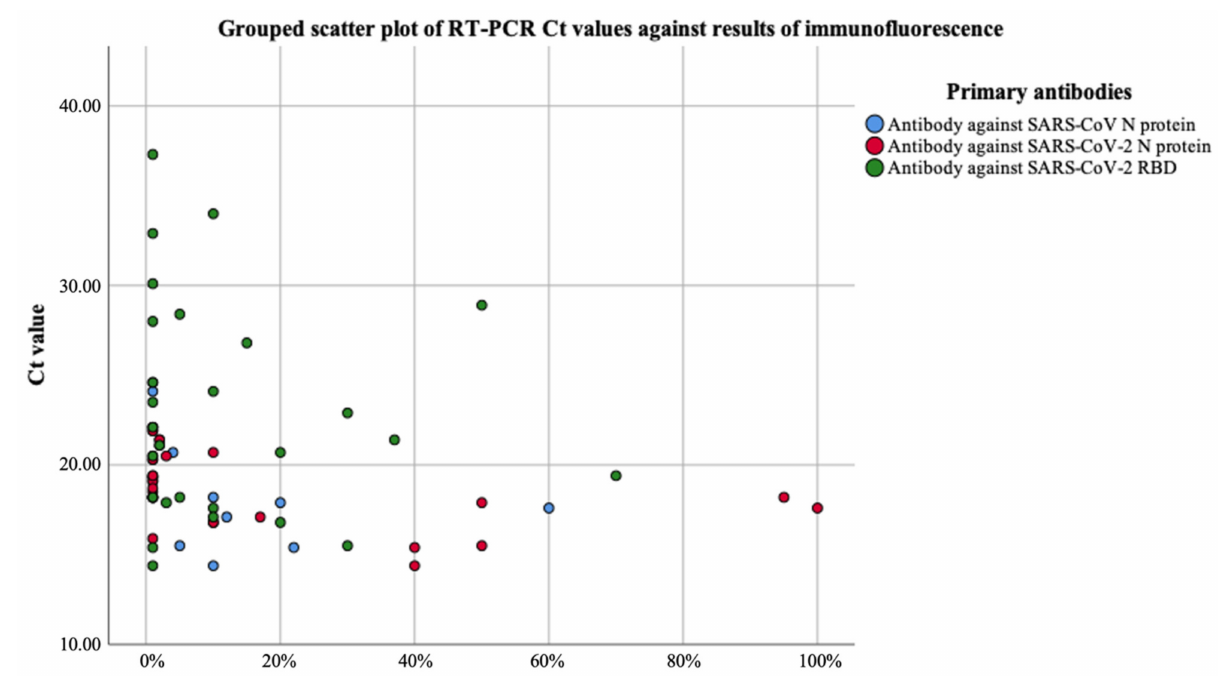
Figure 4. Grouped scatter plot of RT-PCR Ct values against results of indirect